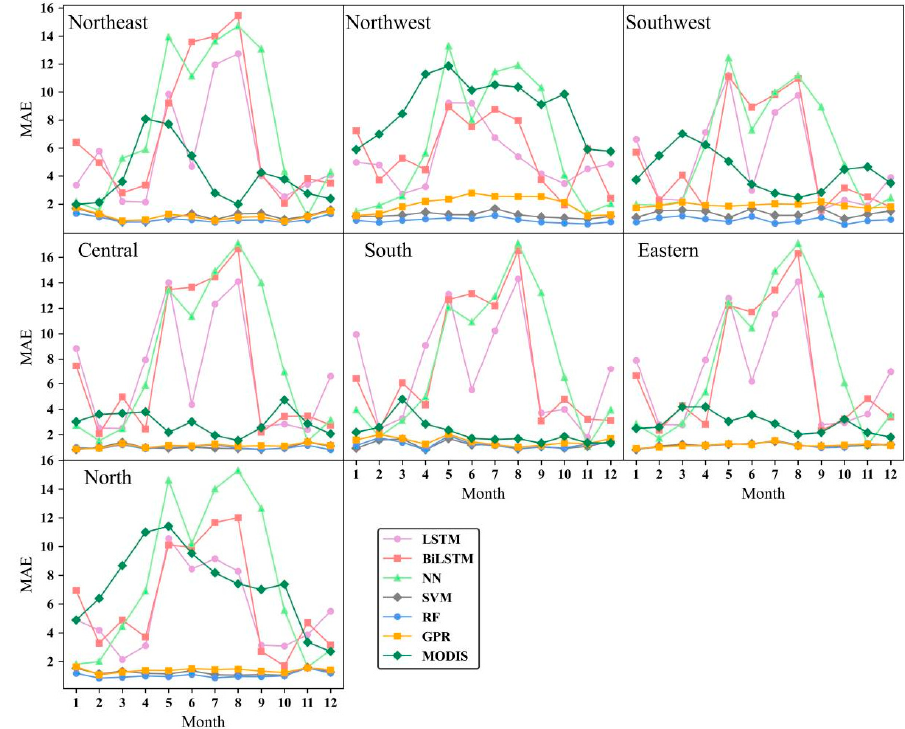
Figure 16. MAE values by month for different regions.